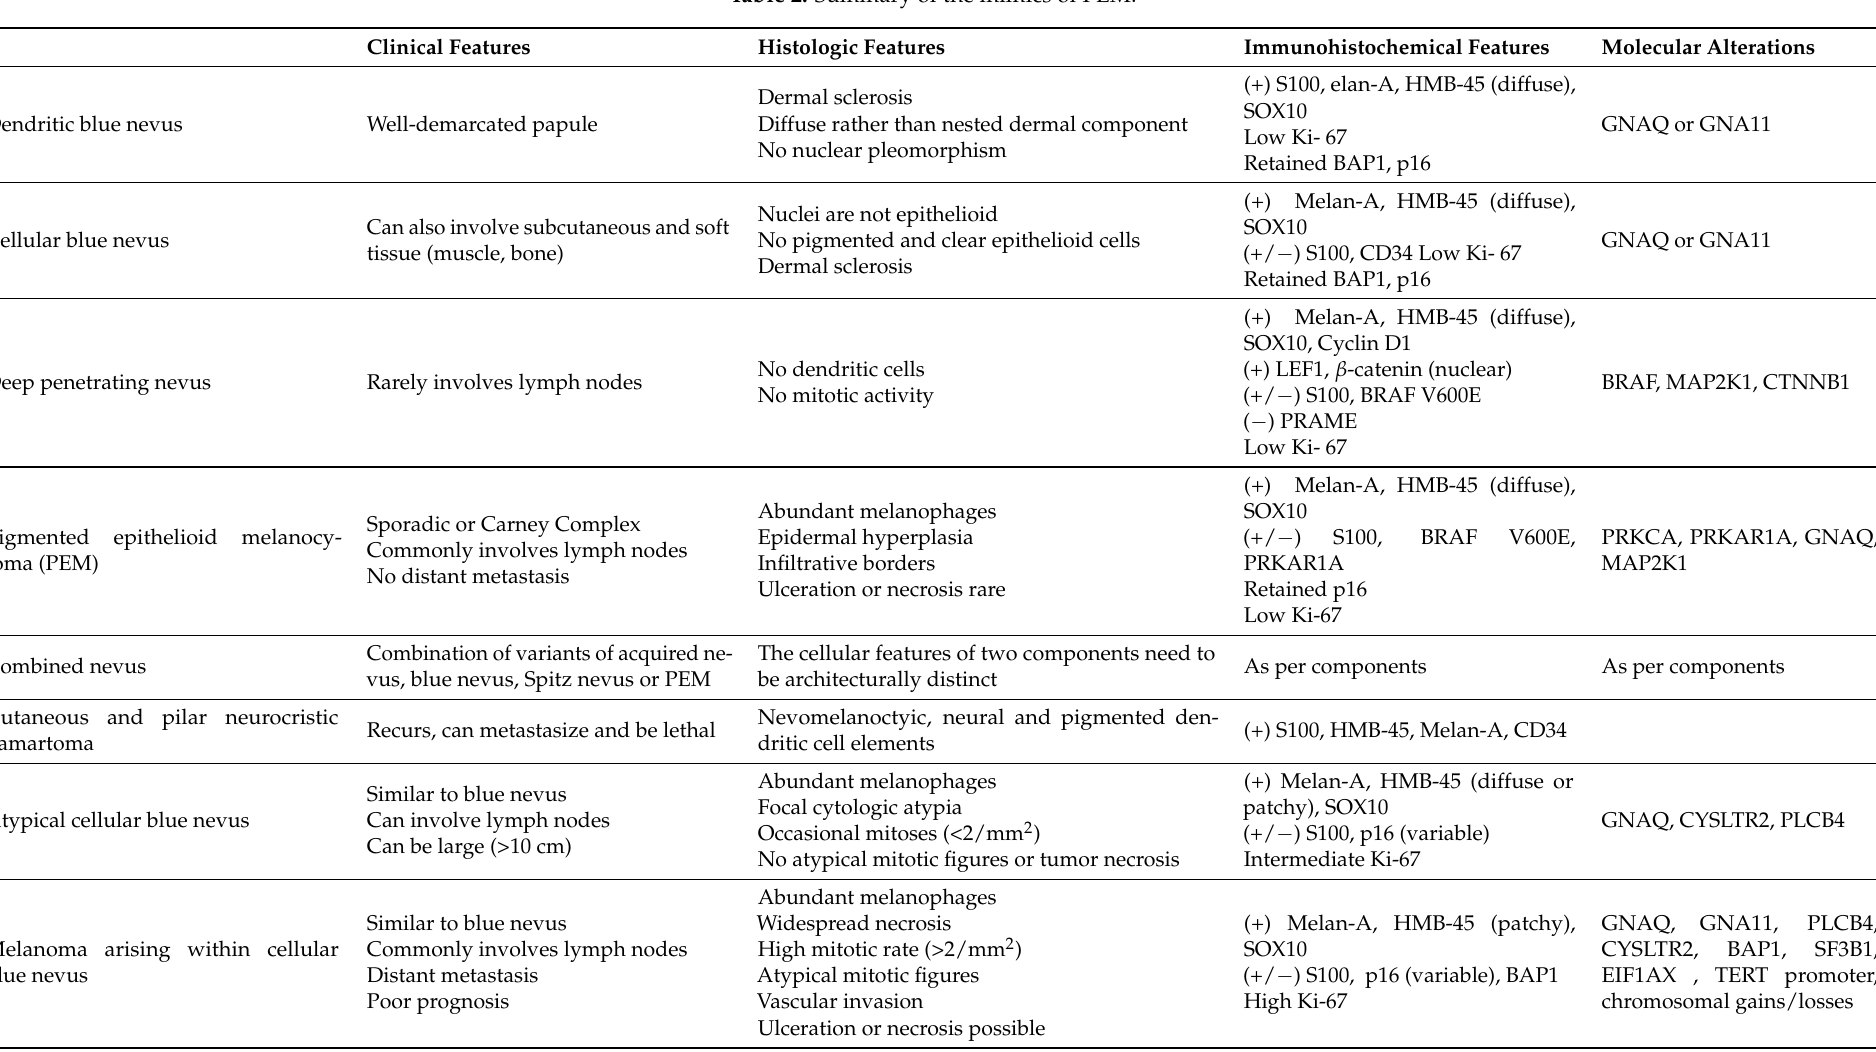
Table 2. Summary of the mimics of